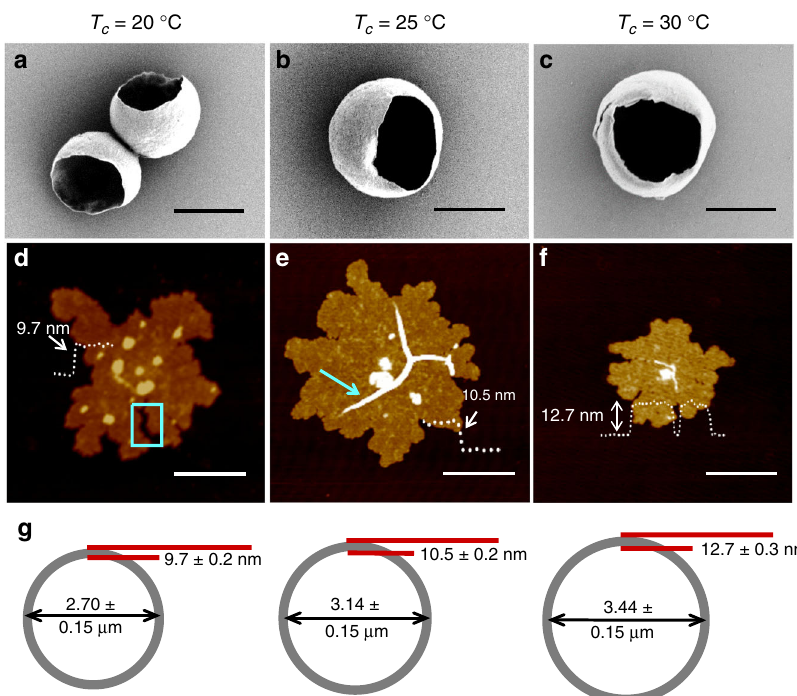
Fig. 3 Manipulating PEO mBBC sizes via T c . ( a – c ) SEM images of mBBCs and ( d – f ) AFM images of small mBBC pieces crystallized at T c = 20 ( a , d ), 25 ( b , e ) and 30 °C ( c , f ). ( g ) Schematics depicting the correlation between mBBC size and shell thickness; value = average ± standard deviation (based on measurements of ten mBBCs). The box in ( d ) and arrow in ( e ) respectively show a crack and a corrugation formed due to fl atening of the crystals. Scale